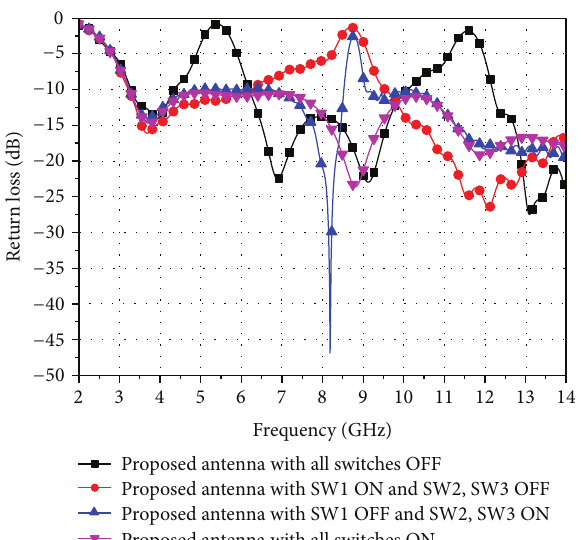
Figure 6: Return loss of switchable characteristics of CRA A.